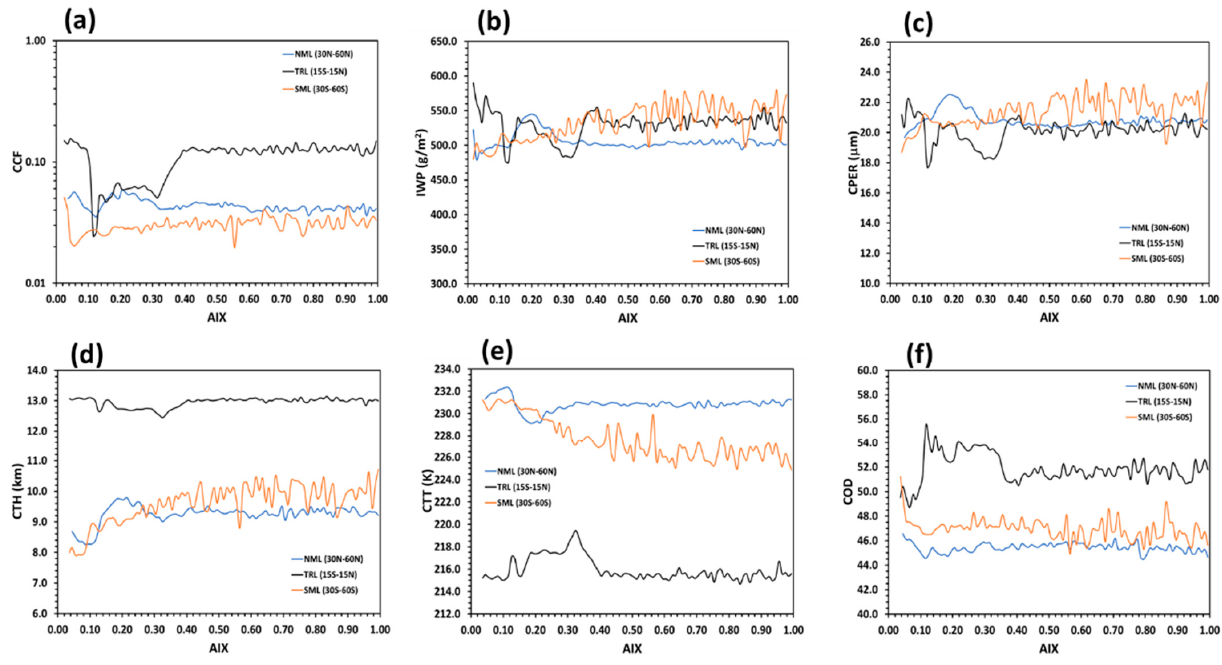
Figure 5. Statistic relationships of AIX with ( a ) CCF, ( b ) IWP, ( c ) CPER, ( d ) CTH, ( e ) CTT, and ( f ) COD for their long-term averaged values in the three latitudinal regions (NML, TRL, and SML). For the NML, large variations of the six cloud variables are mainly observed between 0.1 and 0.32 of AIX and most of the sample numbers also fall in this regime. Thus, the range of AIX from 0.1 to 0.32 is the potential regime (or sensitive regime) where the aerosol effect on DCCs might manifest. In this regime, CCF, CPER, IWP, and CTH are relatively high, CTT is relativly low, and COD is relatively flat, in contrast generally to the TRL. A